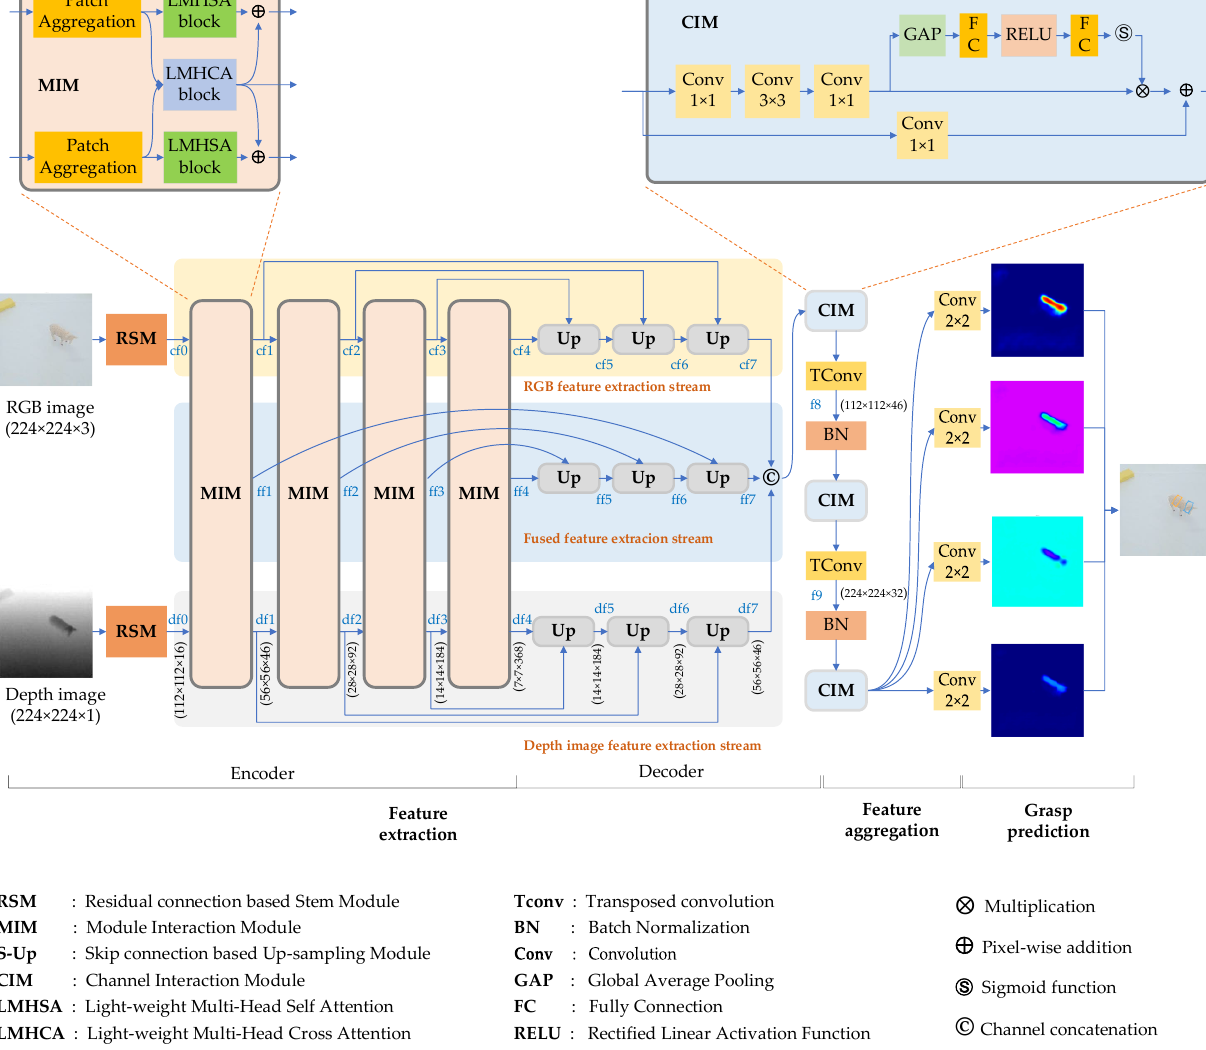
dalities. This process is accomplished through three streams: the RGB feature extraction